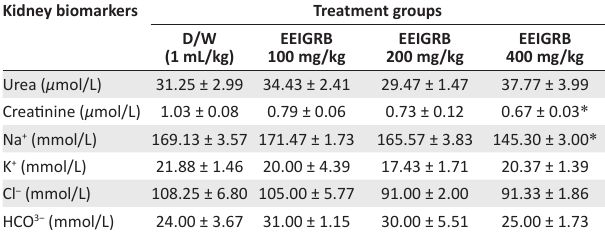
TABLE 3: Effect of 28 days of oral administration of ethanol extract of Irvingia gabonensis root bark on the renal indices of Wistar